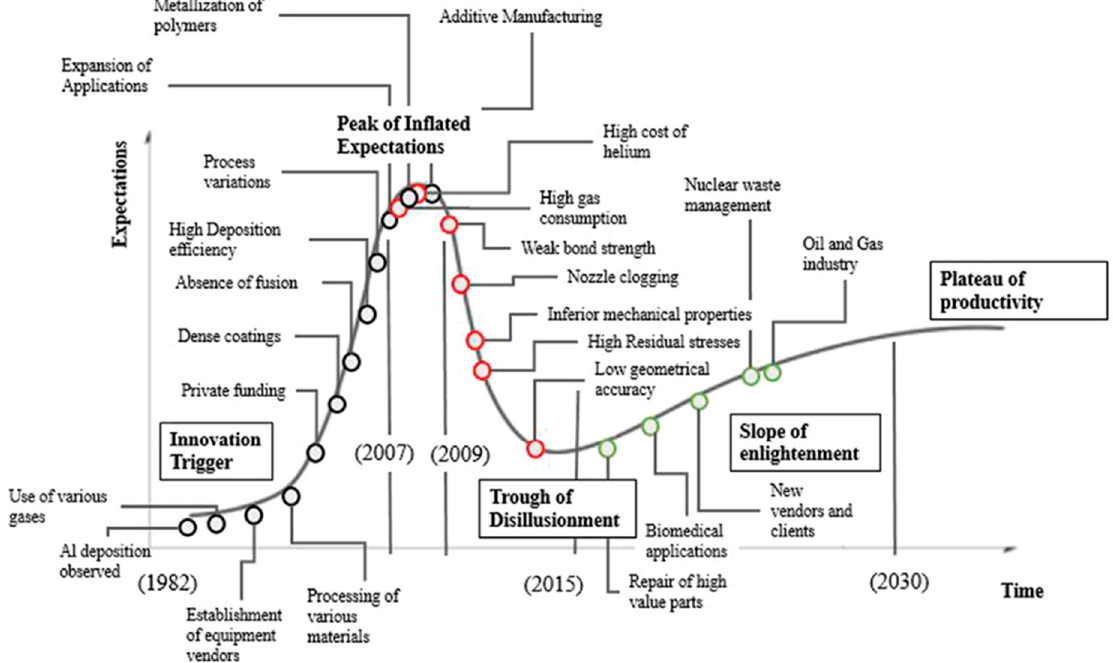
Figure 3. Technology and innovation maturation timeline and projection for cold spray technology [9].